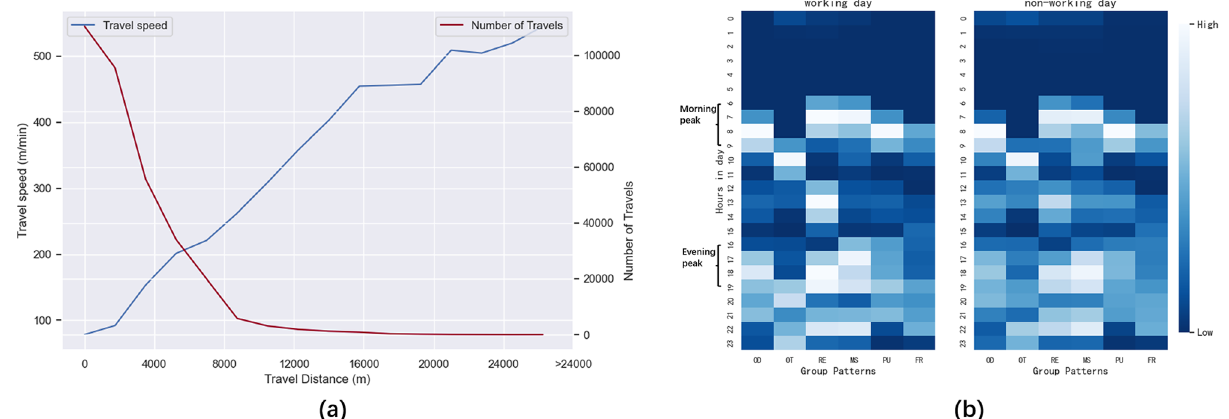
Figure 8. Trajectory statistics. Travel distance with travel speed and the number of travel ( a ) and Heat maps of the travel of different groups on working and non-working days ( b ). ( a ) We define all trips from a place to a new place as one trip, and since the places we set do not contain metro stations and bus stops, the duration of trips using public transportation is much higher. Distance refers to the straight-line distance between the origin and destination of a trip rather than the accurate distance traveled. ( b ) To facilitate comparison, we normalize the number of people in travel for each group and mark the morning peak and evening peak periods.